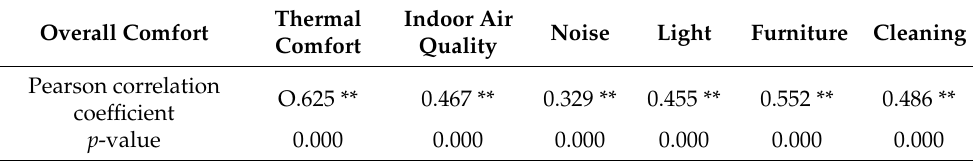
Table 7. Pearson correlation between overall IEQ comfort and IEQ